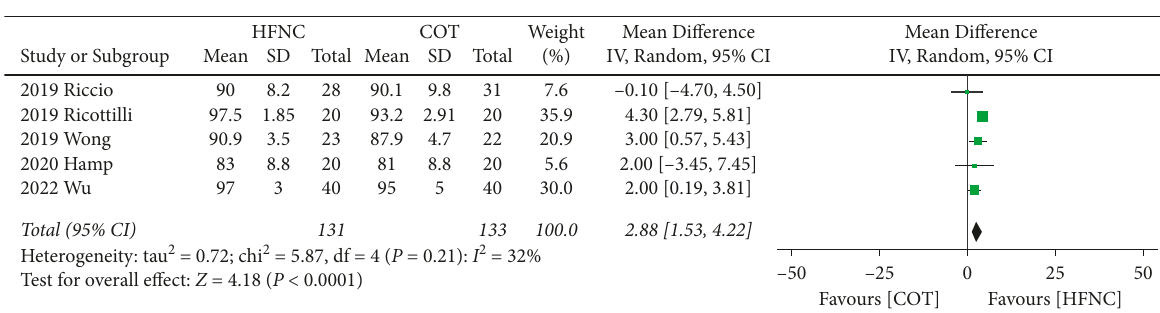
2 between HFNC and COT.